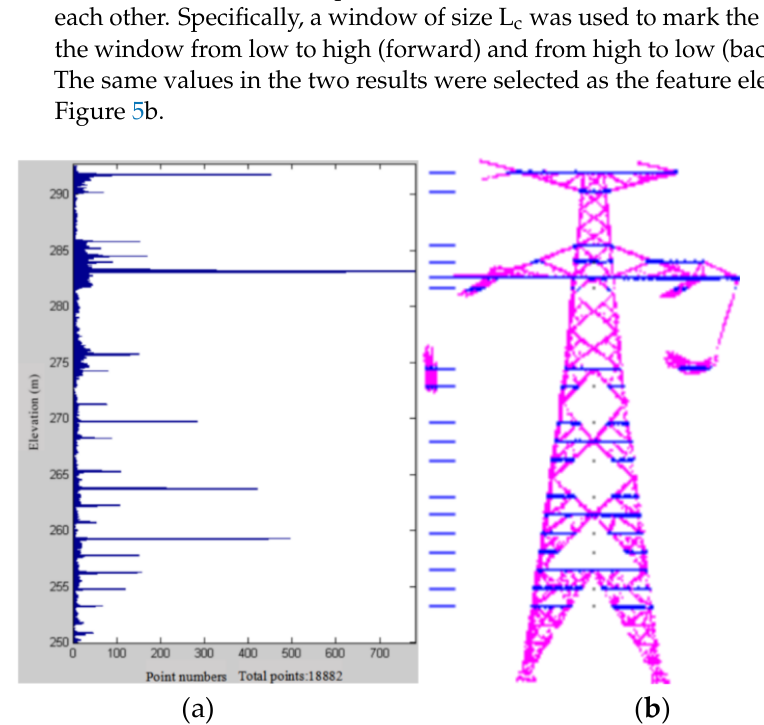
Figure 5. Feature plane extraction based on the elevation histogram. ( a ) histogram of elevation distribution; ( b ) feature plane extraction result.